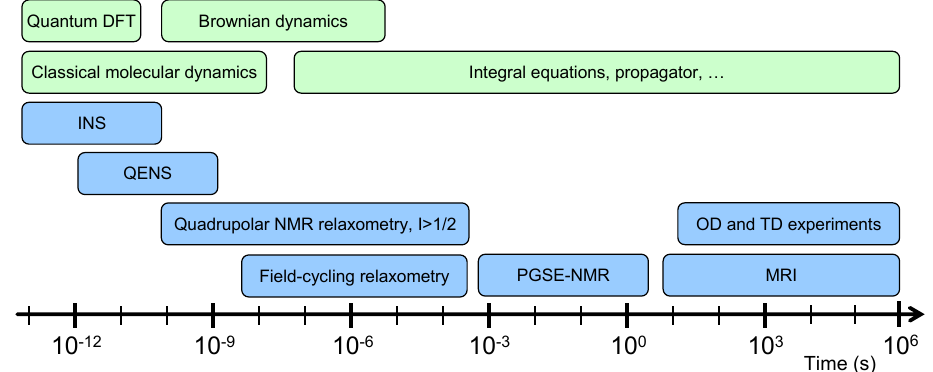
Figure 1. Schematic view of the time-scales probed by the various experimental methods (blue) and the numerical modeling